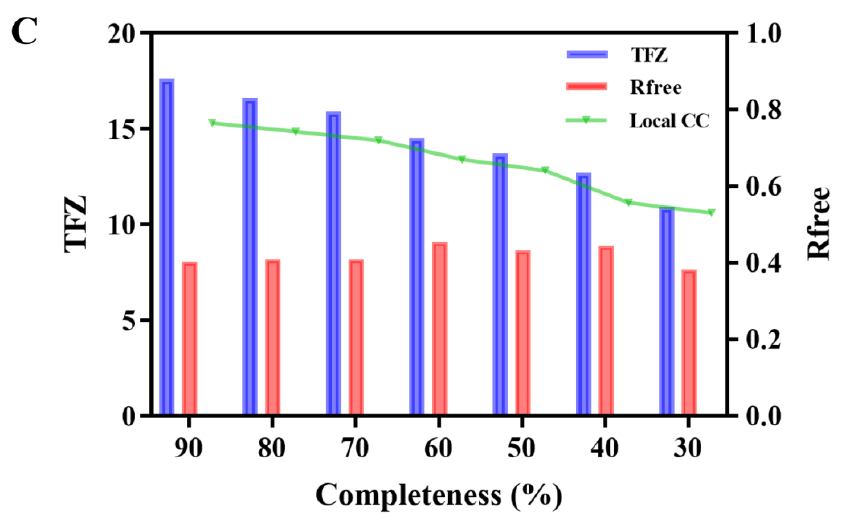
Figure 5. Influence of data quality on crystal structural determination with the aid of the AF2 model. The blue bar represents the best TFZ obtained from each MR trial. The red bar represents the Rfree factor given by Phenix.refinement . The green line indicates the local CC between each initially refined electron density map and the final crystal structure. ( A ) Effect of data error. ( B ) Effect of data resolution. ( C ) Effect of data